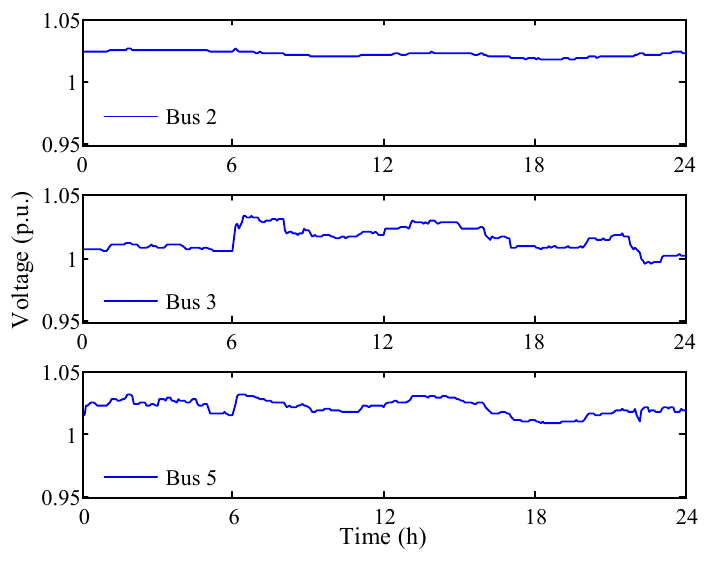
Figure 10. Voltage of the typical buses in the MG.